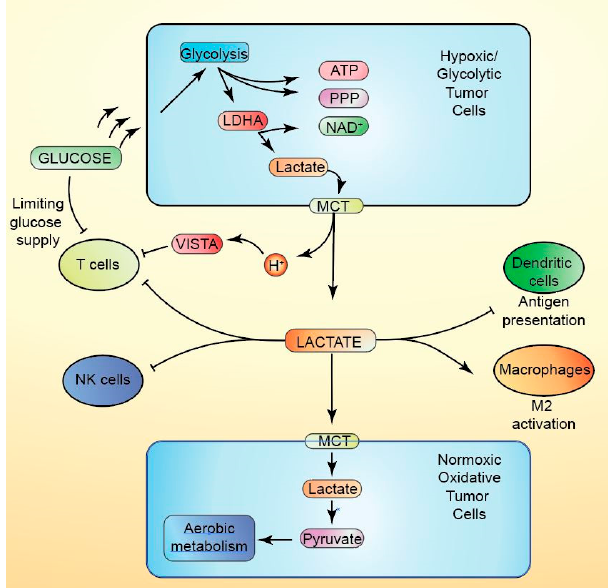
Figure 3. Lactate metabolism in the tumor microenvironment. Rapid glucose uptake by tumor cells, particularly hypoxic cells, depletes glucose from the tumor microenvironmen (TME), thus limiting glucose availability for T cells. Rapid glycolysis in tumors provides a ready supply of ATP and anabolic intermediates; NAD + is regenerated to avoid reductive stress by the production of lactate by LDHA (lactate dehydrogenase A). Lactate is then exported by MCT (monocarboxylate transporter) family members to the TME, where it accumulates and acidifies the TME. Oxidative tumor cells can take up lactate and convert it to pyruvate to supply acetyl CoA for aerobic metabolism. High levels of lactate directly suppress T cell and natural killer cell function in the TME. The acidification of the TME suppresses T cell response via activation of VISTA (V-domain Immunoglobulin suppressor of T cell activation) signaling. Lactate further suppresses TME immune surveillance by blocking antigen presentation by dendritic cells and promoting M2 activation of